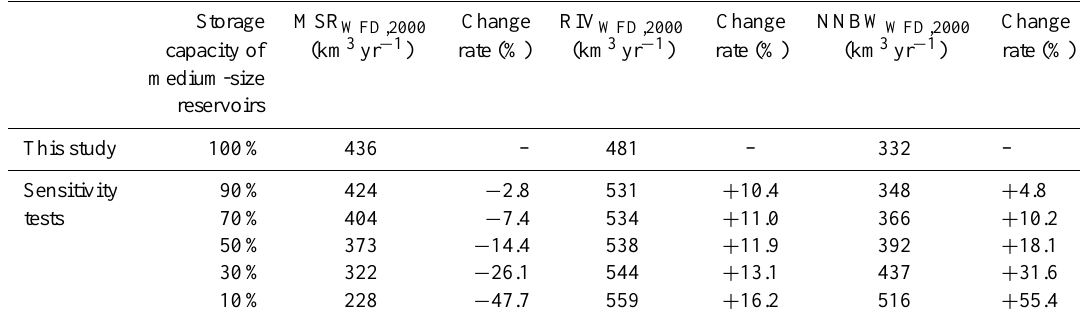
Table 4. Sensitivity study of MSR WFD,2000 with regard to 90, 70, 50, 30 and 10% storage capacity in medium-size reservoirs.